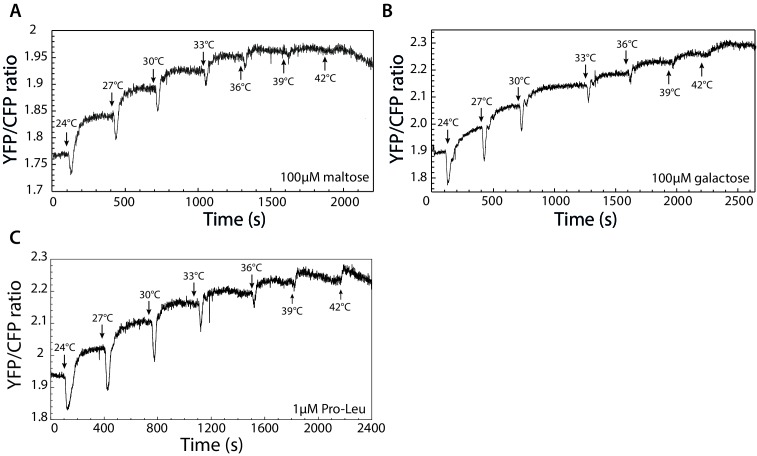
Indirectly binding ligands do not invert thermotactic response.(A–C) Response to stepwise changes in temperature was measured for cells adapted to 100 µM maltose (A), 100 µM galactose (B), or 1 µM dipeptide Pro-Leu (C).